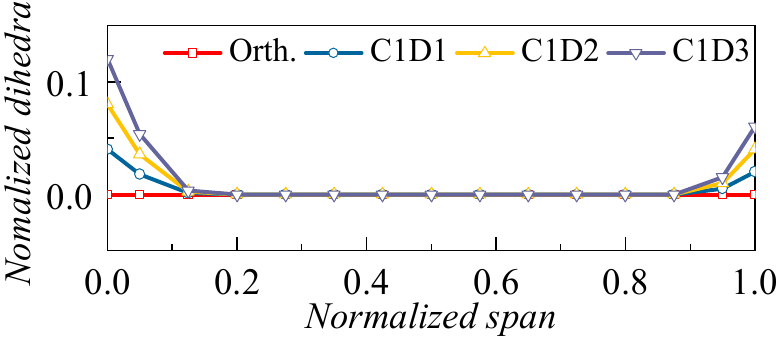
Figure 19. Radial distribution of blade dihedral for the cases with different dihedral angles.